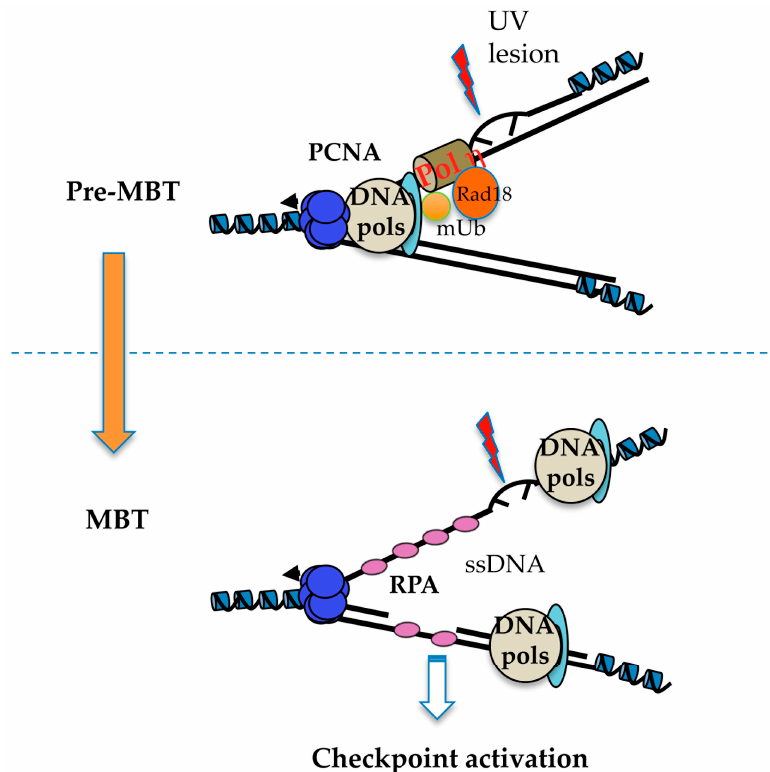
Figure 5. A DNA damage ‐ tolerant replisome in early embryos? Speculative representation of replisome structure in pre ‐ and post ‐ MBT embryos. In pre ‐ MBT embryos, constitutive PCNA mUb , driven by high RAD18 expression, allows recruitment of TLS Pol η to replication forks thus limiting replication fork uncoupling in front of DNA damage (UV ‐ C lesions in this example). In this situation, formation of ssDNA, which is a prerequisite for checkpoint activation, is strongly reduced. In post ‐ MBT embryos that contain reduced RAD18 levels, PCNA mUb requires ssDNA formation, thus leading to checkpoint activation.